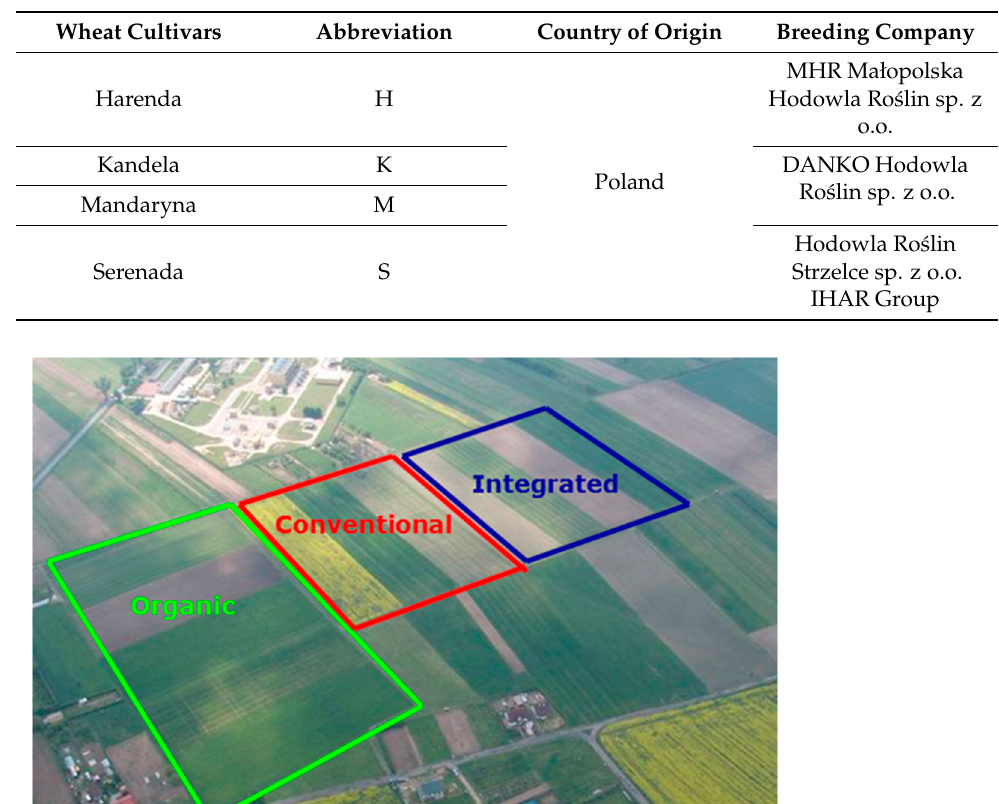
Table 3. List of wheat cultivars tested.